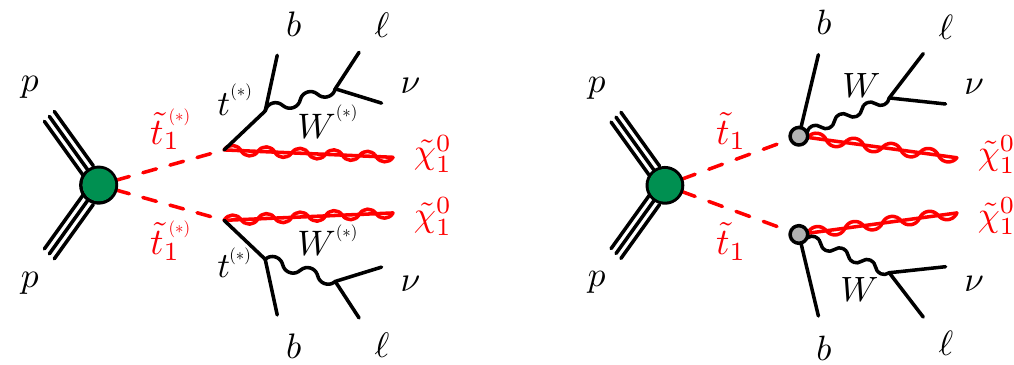
Figure 2 . The left diagram illustrates the full process for the parameter space where m ( ~ t m ( ~ (cid:31) 0 1 ) < m t including the o(cid:11)-shell propagators which encode the non-trivial kinematic correlations, and the right diagram illustrates the same process in the narrow width approximation. The green circles represent the full tree-level stop pair production matrix element, which is included in our simulations. The gray circles represent decays that do not include any matrix element information, i.e., the particles are decayed using phase space alone. The superscripts ( can go o(cid:11) shell. This (cid:12)gure was adapted from diagrams given in ref. [48].